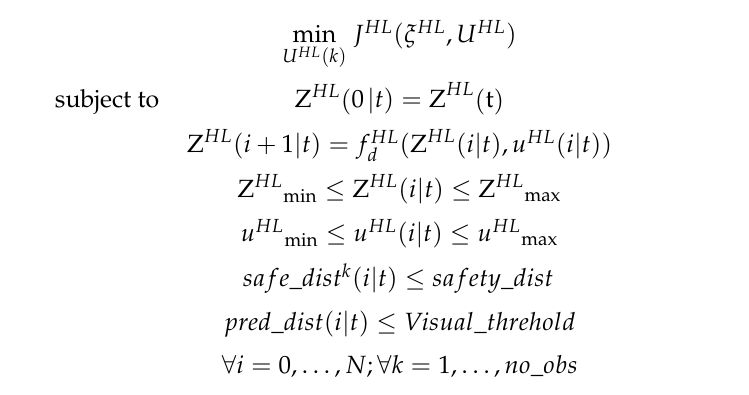
Figure 3. The schematics of the double-layer MPC-based lane tracking method. The upper MPC utilizes a dynamic model described by Equation (3). The sampling time is denoted as ∆ T . The discrete dynamic model is derived using the Euler method. The mathematical expression for the upper MPC can be represented by Equation (26).